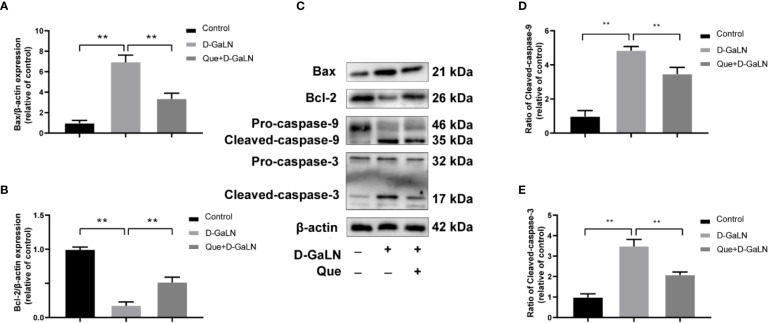
Effect of Que on the expression of d-GaLN-induced apoptosis-related proteins. (A, B, D, E) The relative expression levels of Bax/β-actin, Bcl-2/β-actin, ratio of cleaved caspase-9, and ratio of cleaved caspase-3. The data on quantified protein expressions were normalized by related β-actin (fold change of control); (C) Representative immunoblots for the Bax, Bcl-2, caspase-9, caspase-3, and β-actin proteins. Data are presented as the mean ± SD of three technical replicates (**p < 0.01).